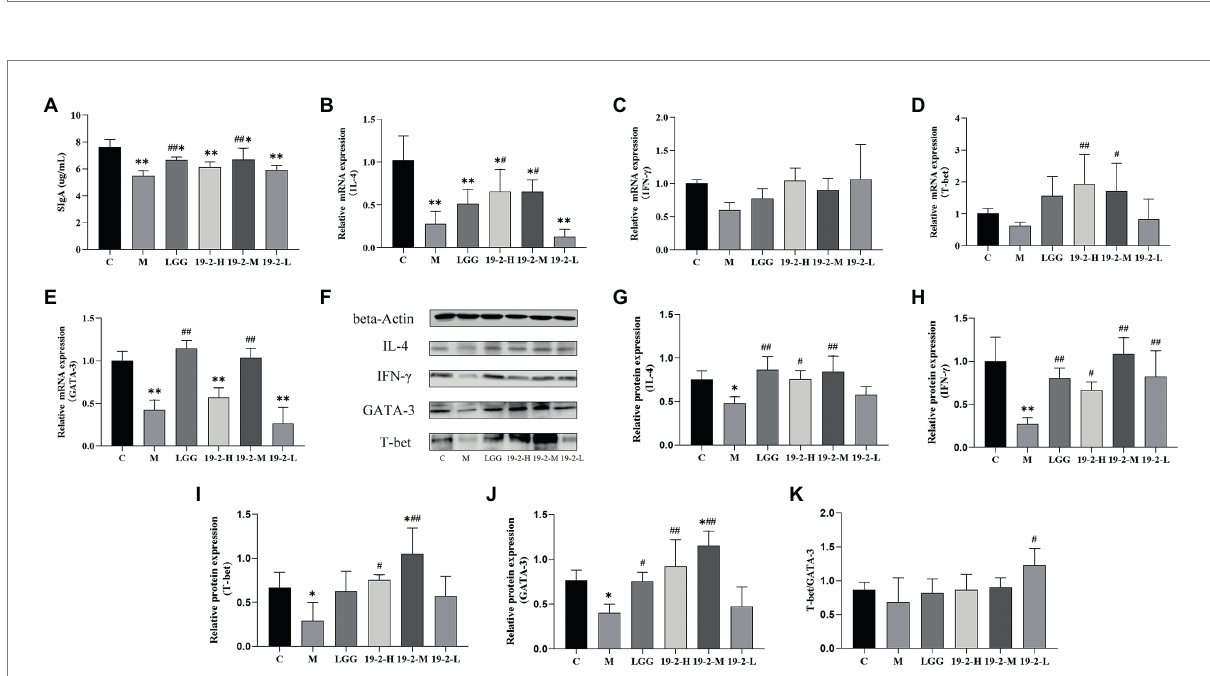
FIGURE 6 Concentration of SIgA and mRNA and protein expression levels of cytokines in the intestinal mucosa. (A) Concentration of SIgA in the small intestinal mucosa. (B–E) The mRNA expression levels of IL-4, IFN- γ , T-bet, and GATA-3. (F) The protein levels of IL-4, IFN- γ , T-bet, and GATA-3. (G–J) Values from densitometry of IL-4, IFN- γ , T-bet, and GATA-3 were normalized to the level of beta-Actin protein. (K) Relative intensities of T-bet/GATA-3 bands. **, * showed significant difference compared with the control group, p < 0.01, p < 0.05; ##, # represent significant difference compared with group M, p < 0.01, p <